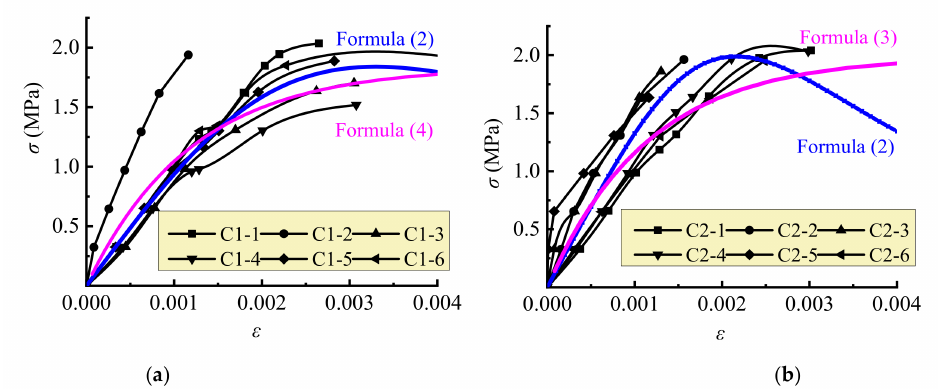
Figure5. Compressivestress–straincurveoftheblockmasonry: ( a )insulationmortarjoint; ( b )thin-layer mortar joint.